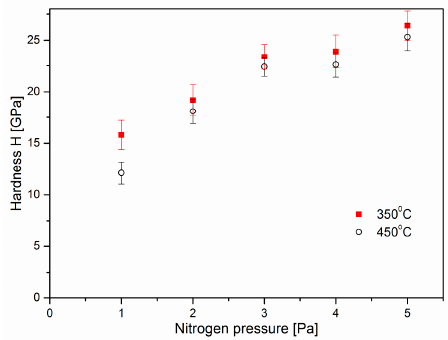
Figure 9. Hardness of AlCrN coatings formed at various nitrogen pressure.